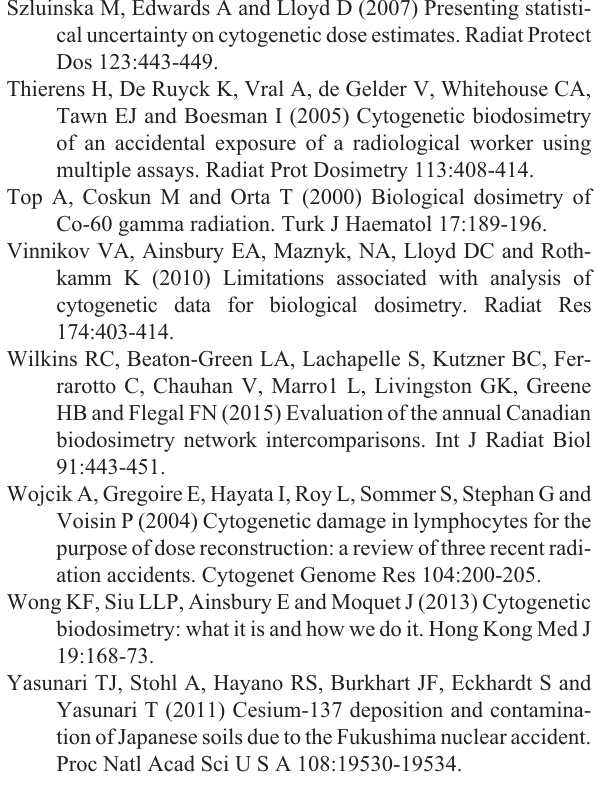
Table S2. Comparison of estimated absorbed doses by se- lected calibration curves using Dose Estimate software. Table S3. Comparison results of estimated absorbed doses by ANOVA after jackknife-like resampling method. Table S4. Results of Tukey’s test after compared all possi- ble pairs of